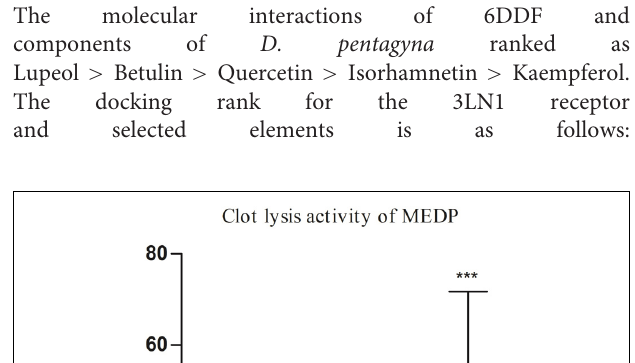
TABLE 4 | Castor oil-induced gastrointestinal motility of the methanol extracts of Dillenia pentagyna . Treatment Dose (mg/kg) Distance